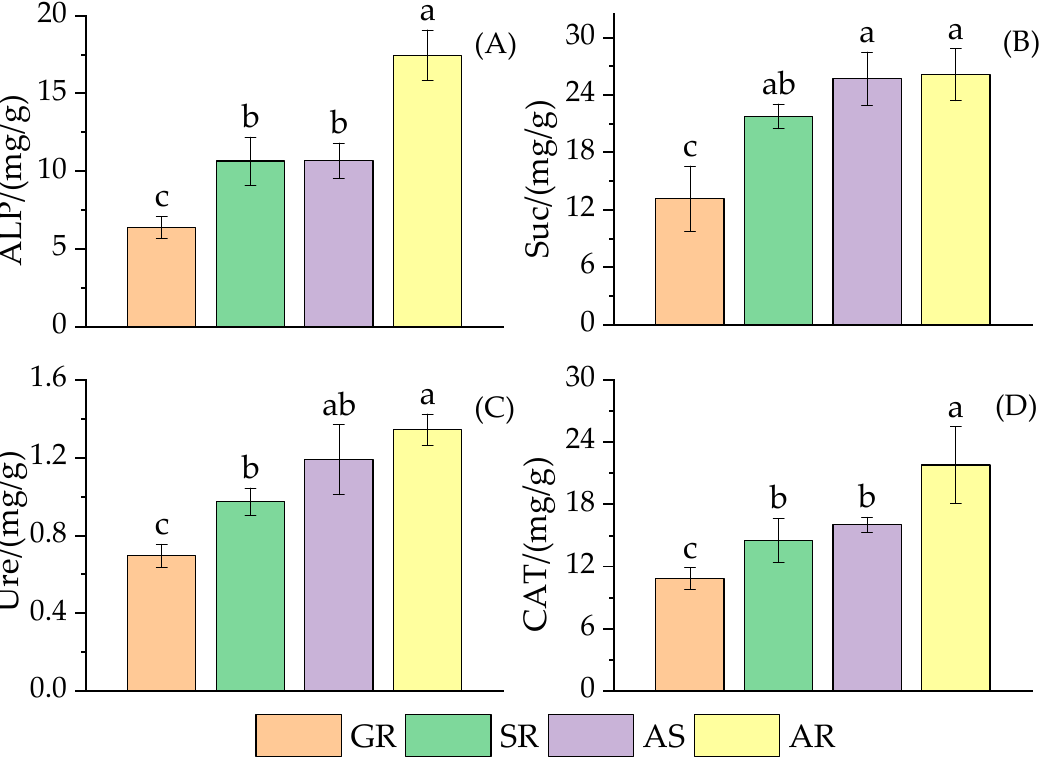
Figure 4. The characteristics of soil enzyme activity in different vegetation types. Note: Subfigure ( A ) = soil ALP activity in different vegetation types, subfigure ( B ) = soil Suc activity in different vegetation types, subfigure ( C ) = soil Ure activity in different vegetation types, and subfigure ( D ) = soil CAT activity in different vegetation types. GR = grassland, SR = shrubland, AS = arbor and shrub compound forest, and AR = arbor forest. The error bar shows the standard deviation of the average. Different lowercase letters indicate significant differences at the 0.05 level ( p < 0.05) between different vegetation types.